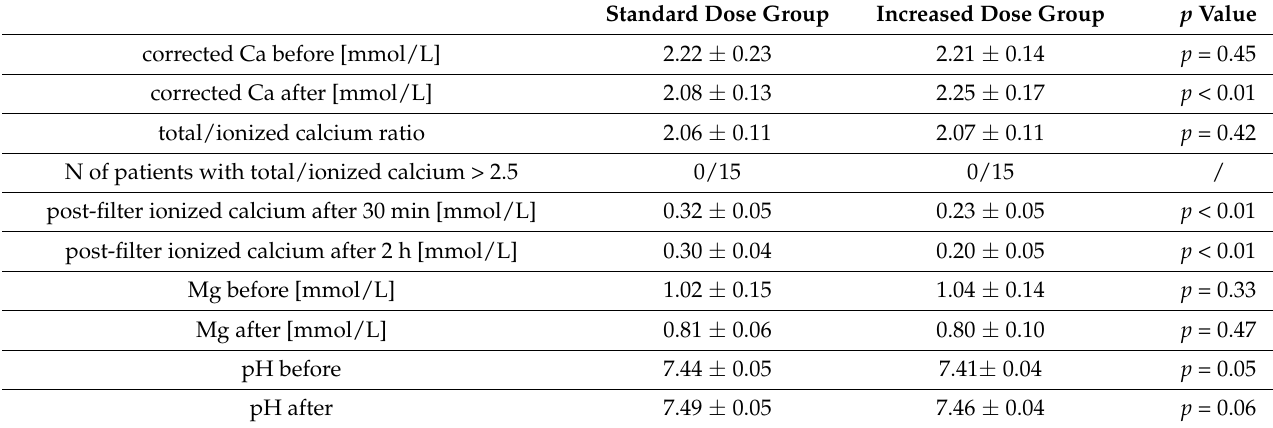
Table 3. Comparison of basic biochemical parameters in both